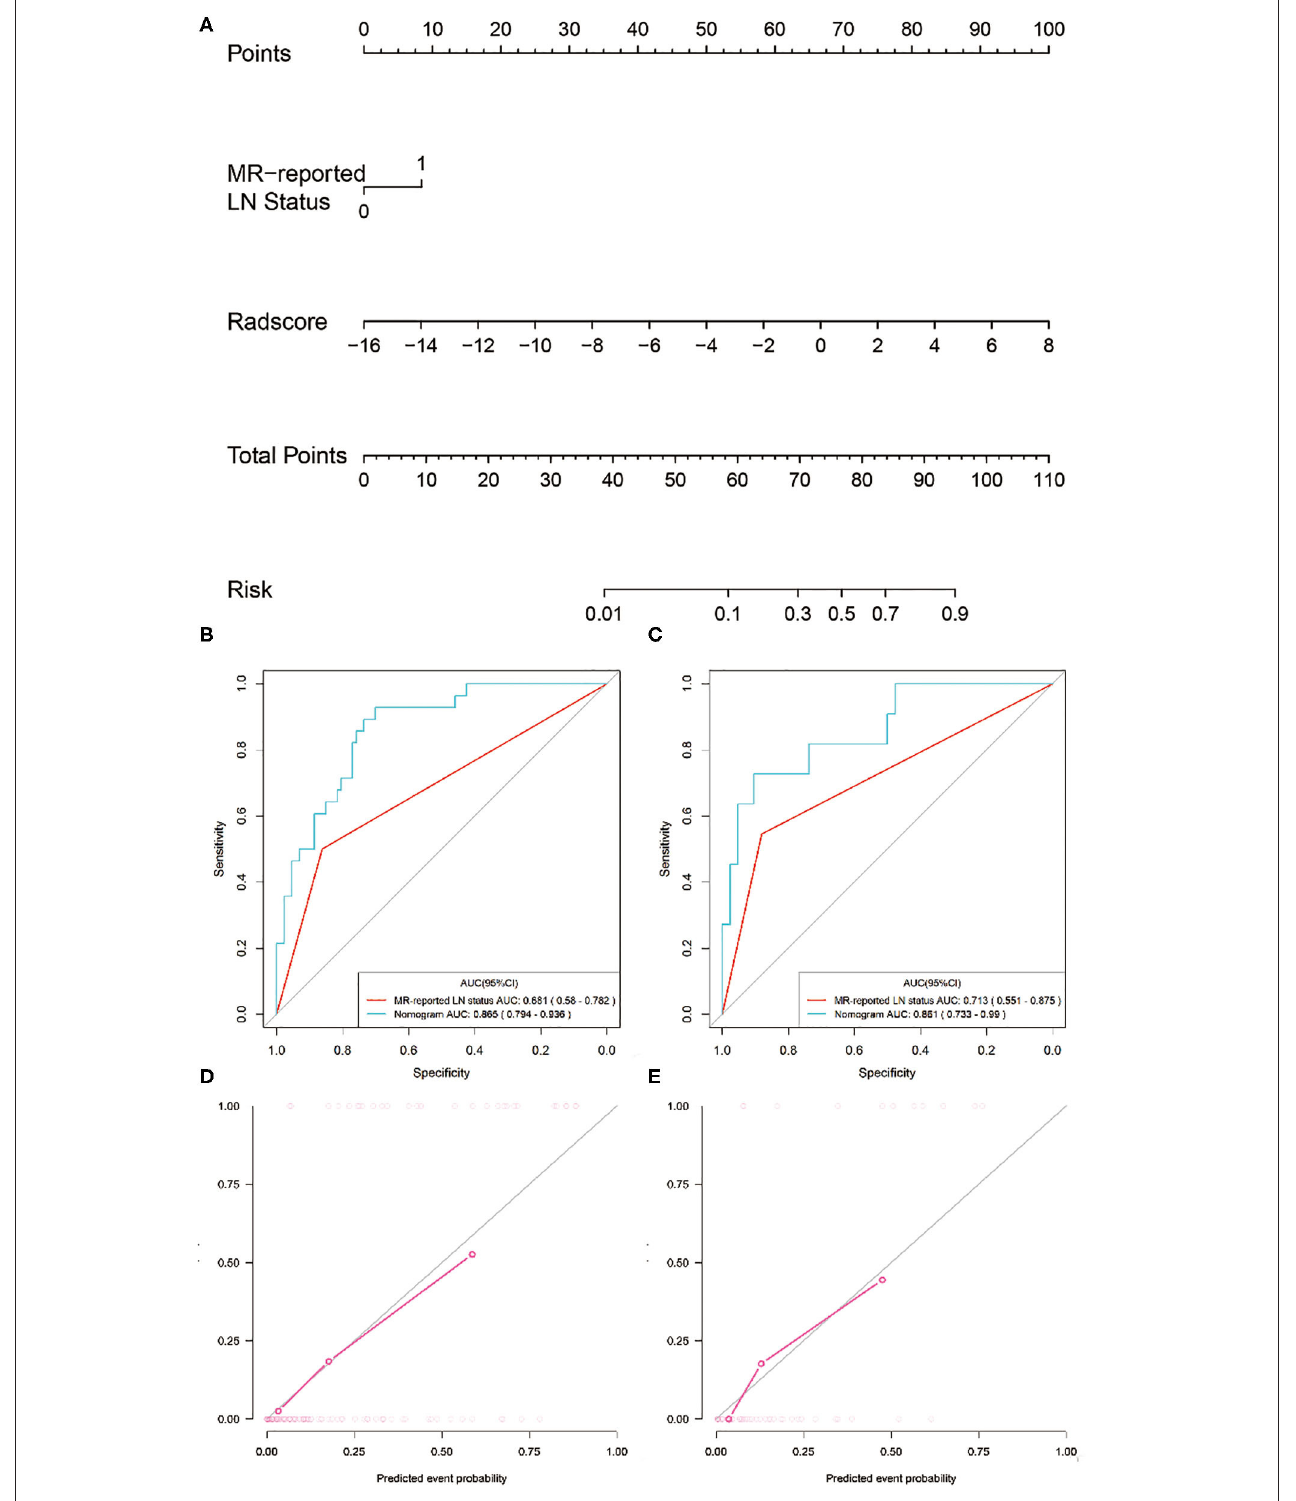
FIGURE 5 | Radiomics nomogram developed with ROC curves and calibration curves. (A) A radiomics nomogram was developed for the prediction of LNM in the training set, with radiomics signature and MRI-reported LN status incorporated. Comparison of ROC curves between the radiomics nomogram and MRI-reported LN status alone for the prediction of LN metastasis in the (B) training and (C) validation sets. Plots (D,E) present the calibration curves of the radiomics nomogram in the training and validation sets, respectively.